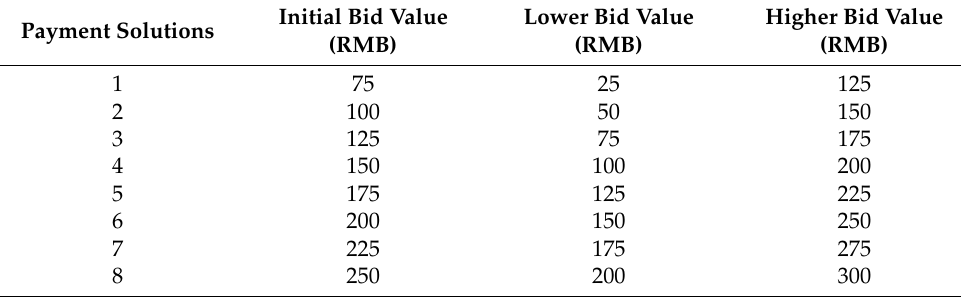
Table 1. Bid values of the double boundary dichotomous